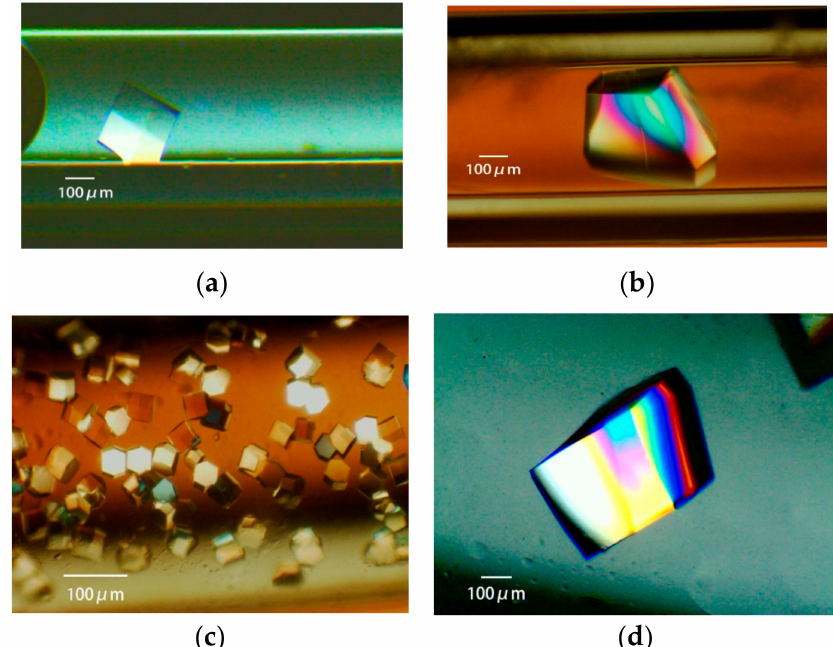
Figure 8. The lysozyme is crystallized with four crystallization methods [31]. ( a ): Batch method. A solution of 18 mg / mL protein, 15% polyethylene glycol (PEG) 4000, 400 mM sodium chloride, and 50 mM sodium acetate bu ff er pH 4.5 is loaded in a 0.5 mm bore capillary. ( b ): Vapor di ff usion method. 20 mg / mL protein in 50 mM sodium acetate bu ff er pH 4.5 is mixed with an equal volume of reservoir solution containing 10% PEG 4000, 600 mM sodium chloride, and 50 mM sodium acetate bu ff er pH 4.5. The mixture is loaded in a 0.5 mm bore capillary, and interacts with the reservoir solution, as shown in [31]. ( c ): Counter di ff usion method. A solution of 25 mg / mL protein, 20% PEG 4000, and 50 mM sodium acetate bu ff er pH 4.5 is loaded in a 1 mm bore capillary. After the Gel-Tube is plugged [31], the capillary is placed in a reservoir solution containing 20% PEG 4000, 1000 mM sodium chloride, and 50 mM sodium acetate bu ff er pH 3.5. ( d ): Dialysis method. A solution of 25 mg / mL protein, 5% PEG 4000, and 50 mM sodium acetate bu ff er pH 4.5 is loaded in a 2 mm bore capillary with a dialysis membrane [31]. The capillary is placed in a reservoir solution containing 10% PEG 4000, 700 mM sodium chloride, and 50 mM sodium acetate bu ff er pH